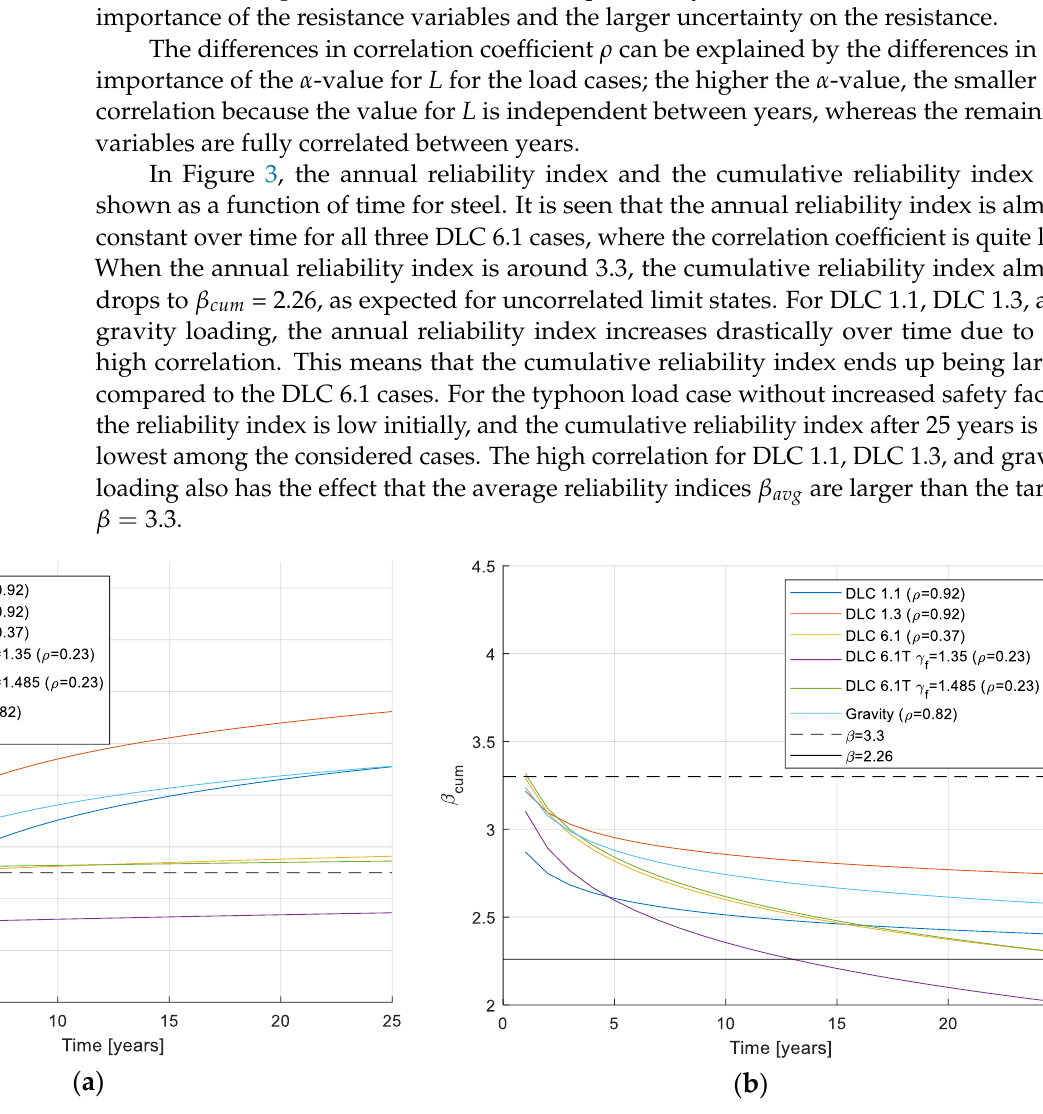
Figure 2. The 𝛼 -vector for ( a ) steel and ( b ) FRP for all load cases.